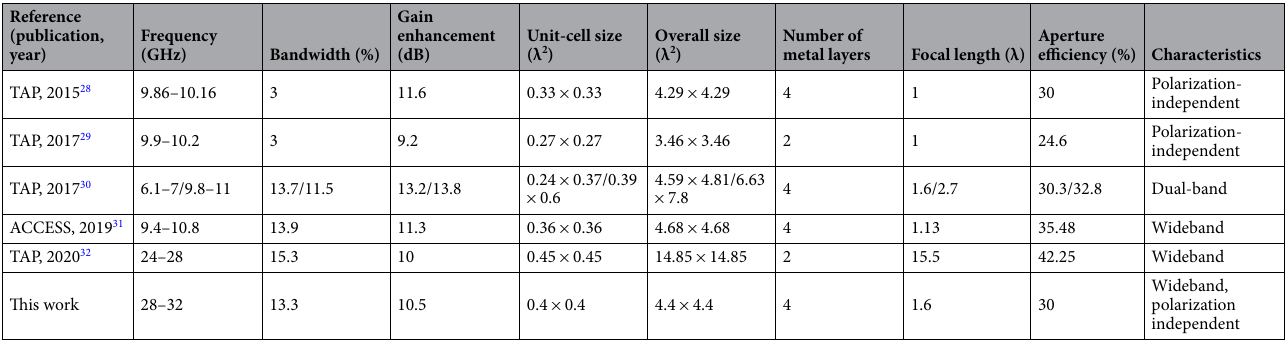
Table 1. Comparison of the proposed metasurface lens with referenced